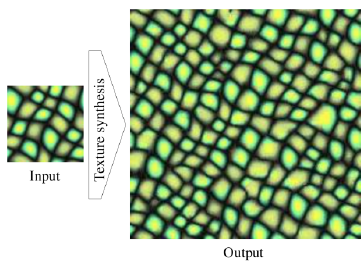
Fig. 1 Texture synthesis. The algorithm is given as inputting a small exemplar consisting of a regular, semi-regular, or stochastic texture image . The algorithm then synthesizes a large, seamless output texture based on the input exemplar. Reproduced with permission from Ref. [1], c (cid:13) The Eurographics Association